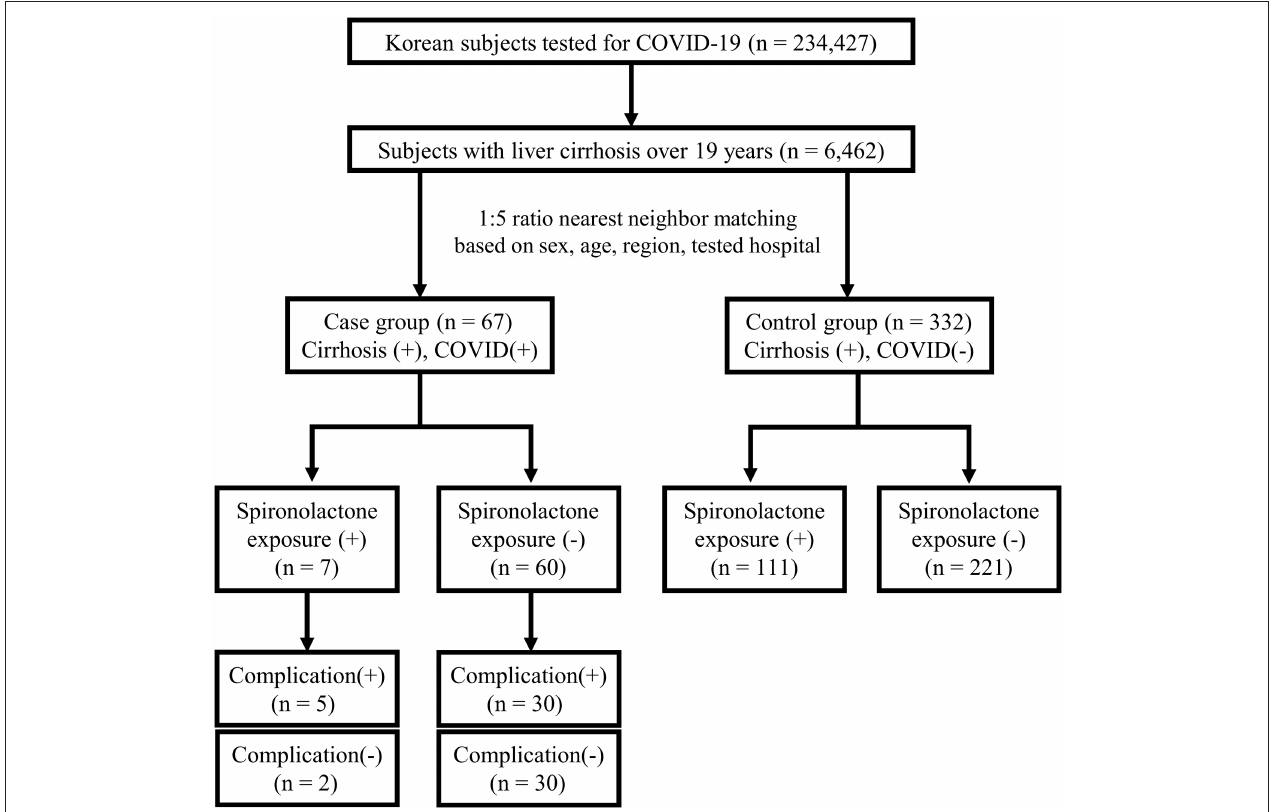
FIGURE 1 | Study flow